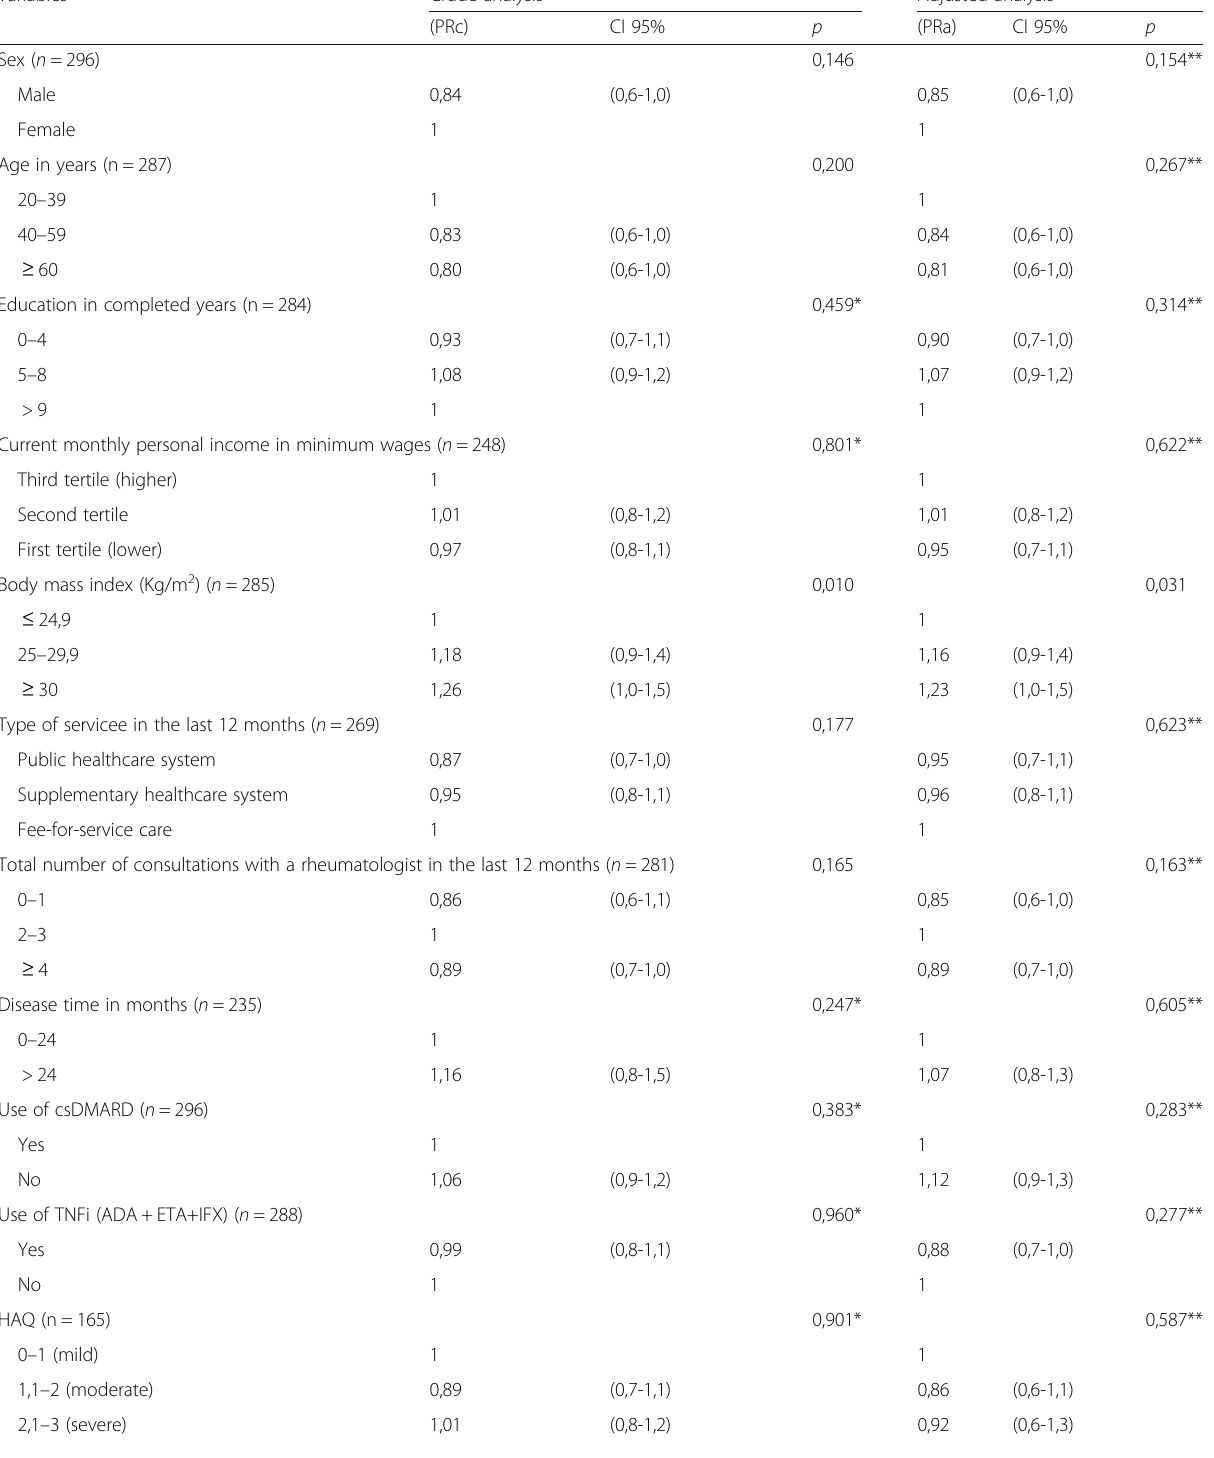
Table 2 Crude and adjusted regression analysis of diagnostic time up to 3 months and independent variables in patients with rheumatoid arthritis in Blumenau, Santa Catarina, Brazil,